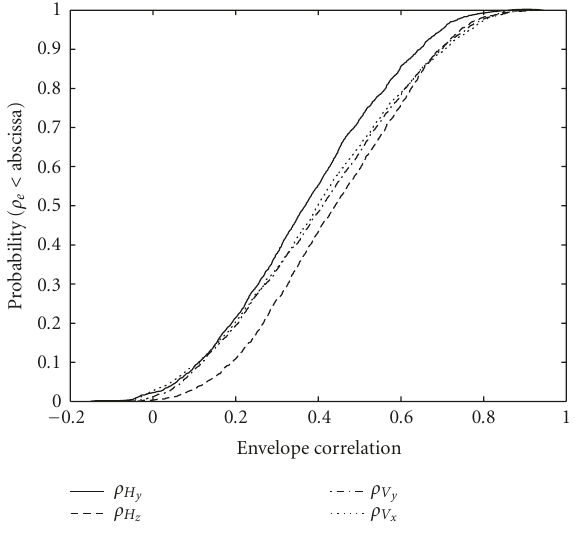
Figure 9: CDF of the envelope correlation (Scenario